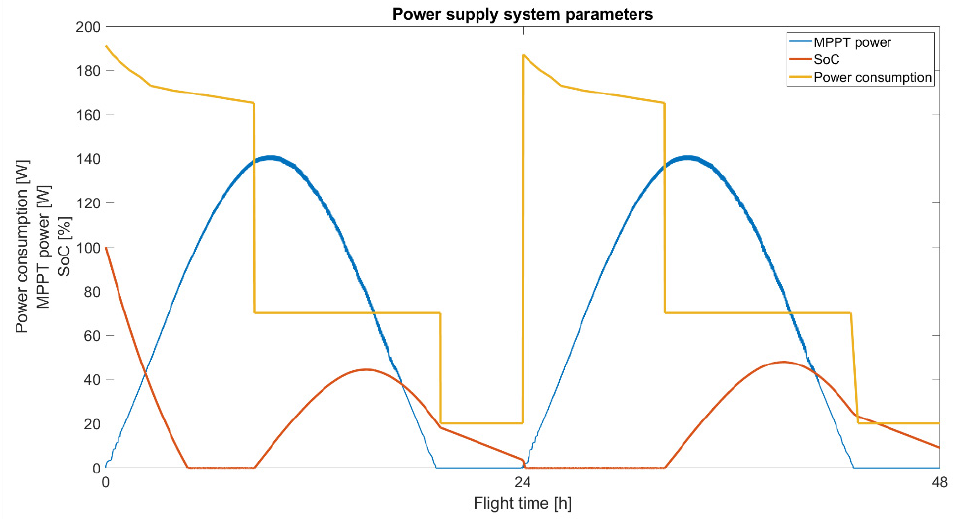
Figure 25. TwinStratos 17 5 km scenario in the summer solstice.